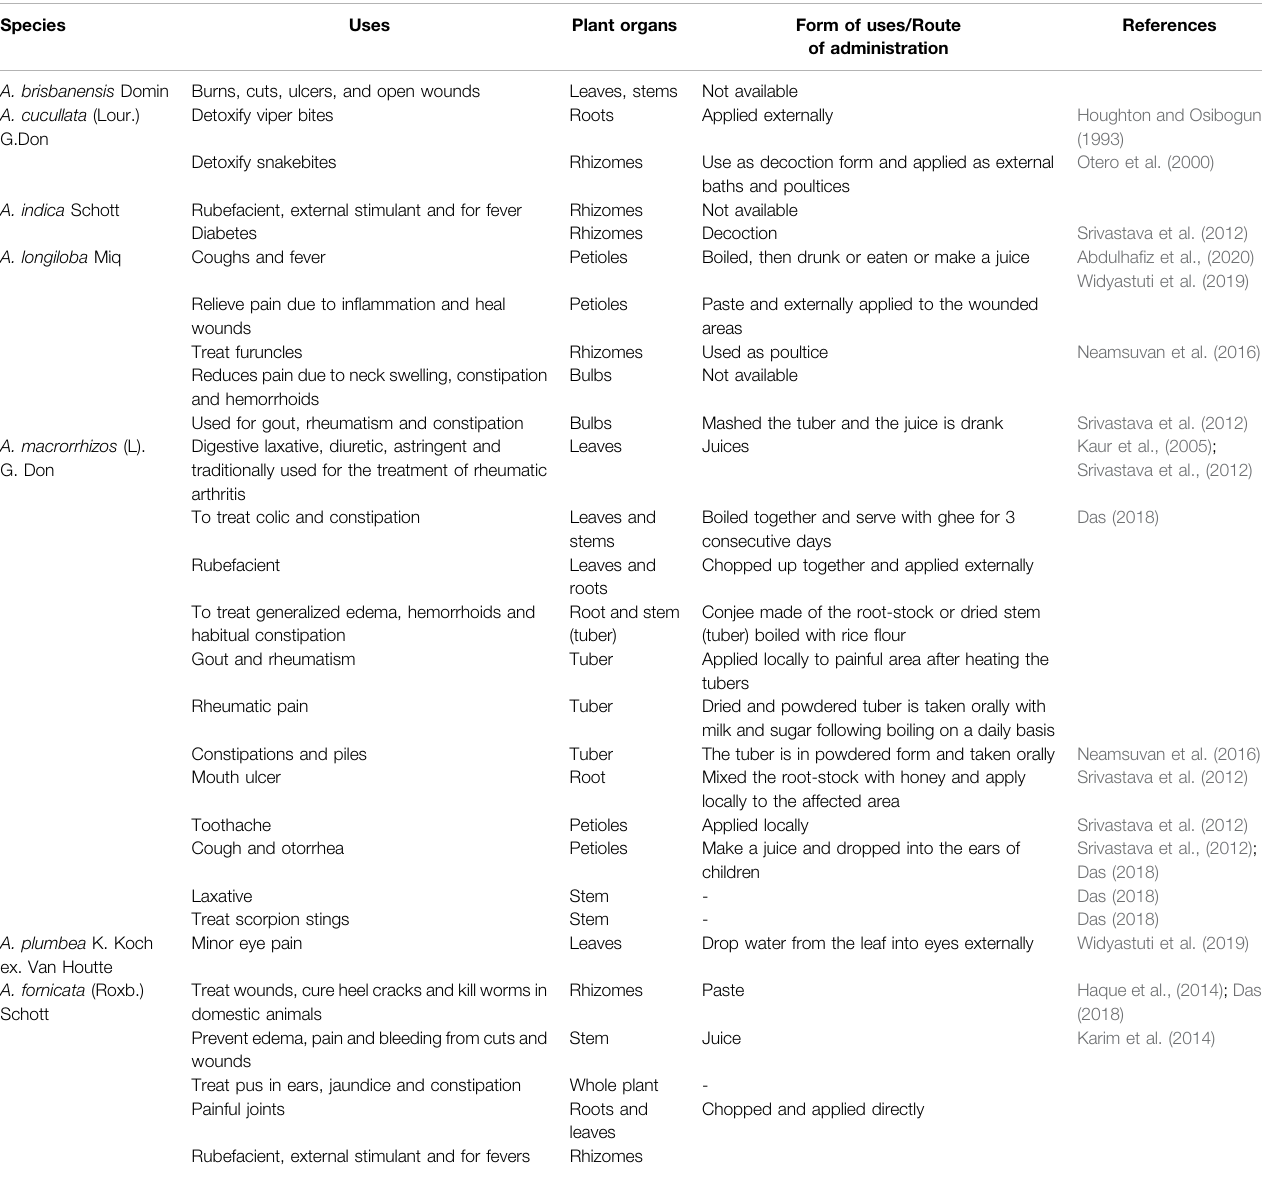
TABLE 2 | Traditional uses of Alocasia species in different countries.